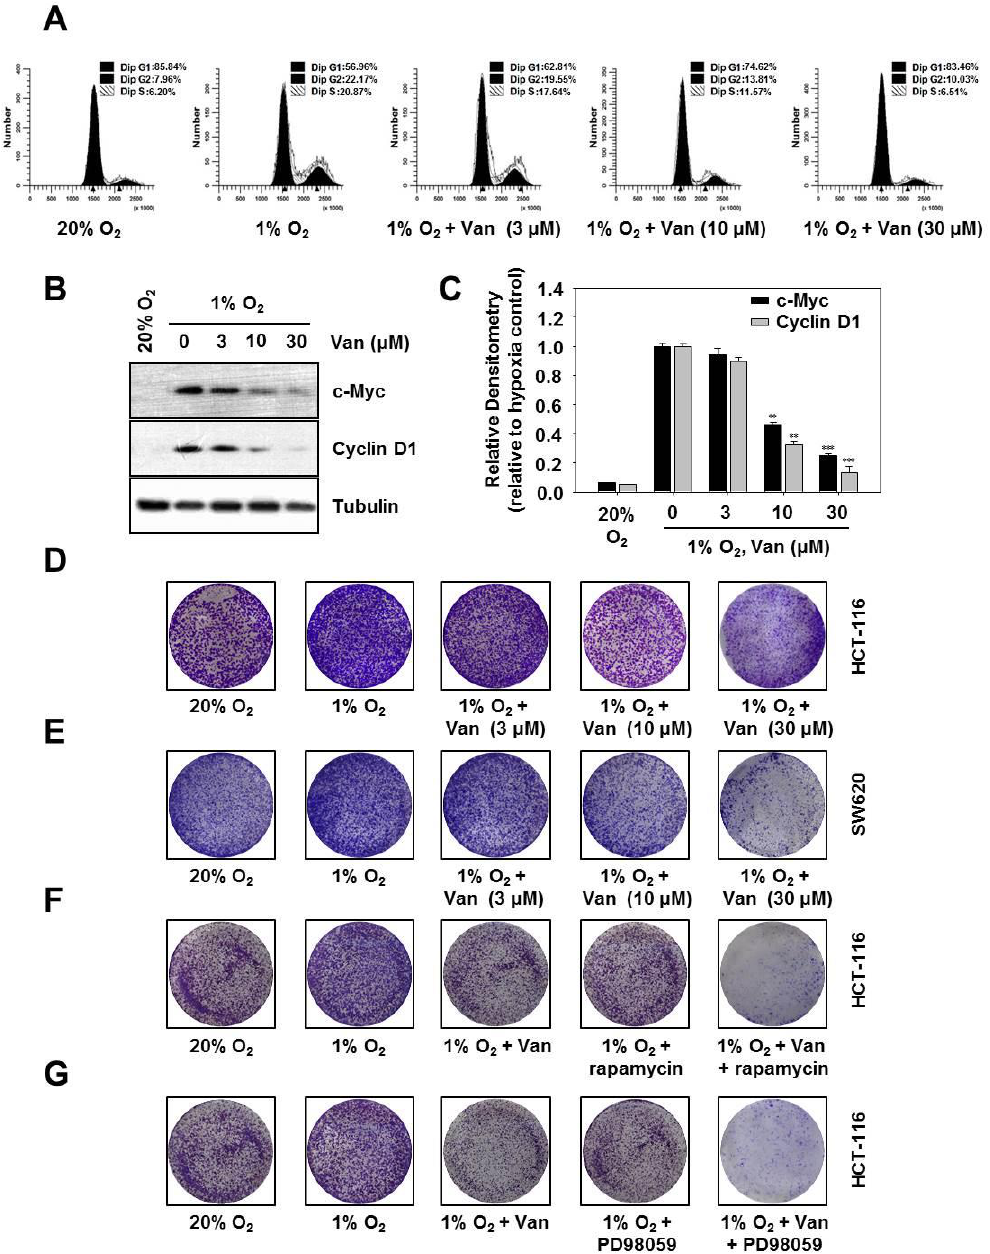
Figure 6. Vanillic acid inhibits the proliferation of HCT116 cells via blocking cell cycle progression in the G1 phase. ( A ) HCT116 cells were pretreated without or with indicated concentration of vanillic acid (Van), then cultured under normoxic or hypoxic conditions for 12 h. Subsequently, cell cycle status was analyzed by FACSCalibur flow cytometry. ( B ) HCT116 cells were pretreated without or with indicated concentration of vanillic acid (Van), then cultured under normoxic or hypoxic conditions for 12 h. Cyclin D1 and c-Myc were detected by Western blot analysis. Levels of tubulin were used as a loading control. ( C ) Data were shown as mean ± SD ( n = 3). ** p < 0.01, *** p < 0.001, compared with hypoxia control. ( D , E ) HCT116 cells and SW620 cells were pretreated without or with indicated concentration of vanillic acid (Van), then cultured under normoxic or hypoxic conditions for 12 h, and then the medium was replaced by fresh medium. Cells were allowed to grow for 10 d in normoxic or hypoxic conditions. ( F , G ) HCT116 cells were pretreated without or with indicated concentration of vanillic acid (30 µ M), rapamycin (100 nM), and PD98059 (50 µ M), cultured under normoxic or hypoxic conditions, and then the medium was replaced by fresh medium. Cells were allowed to grow for 10